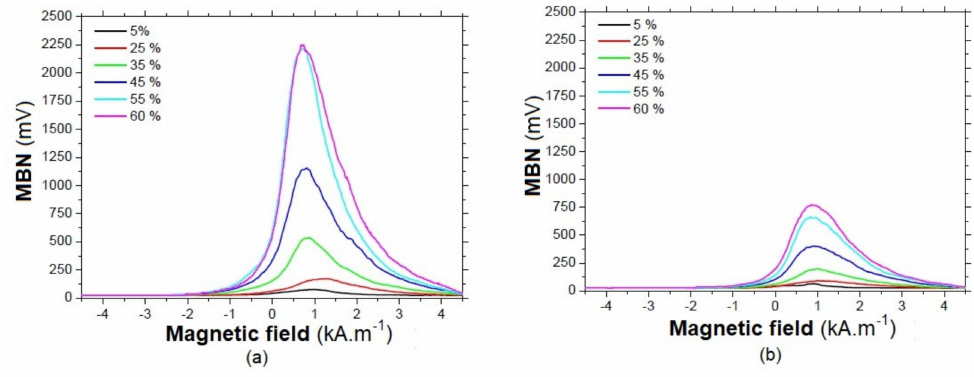
Figure 11. MBN envelopes for different ε and directions of measurement. ( a ) 0 ◦ direction, ( b ) 90 ◦ direction.